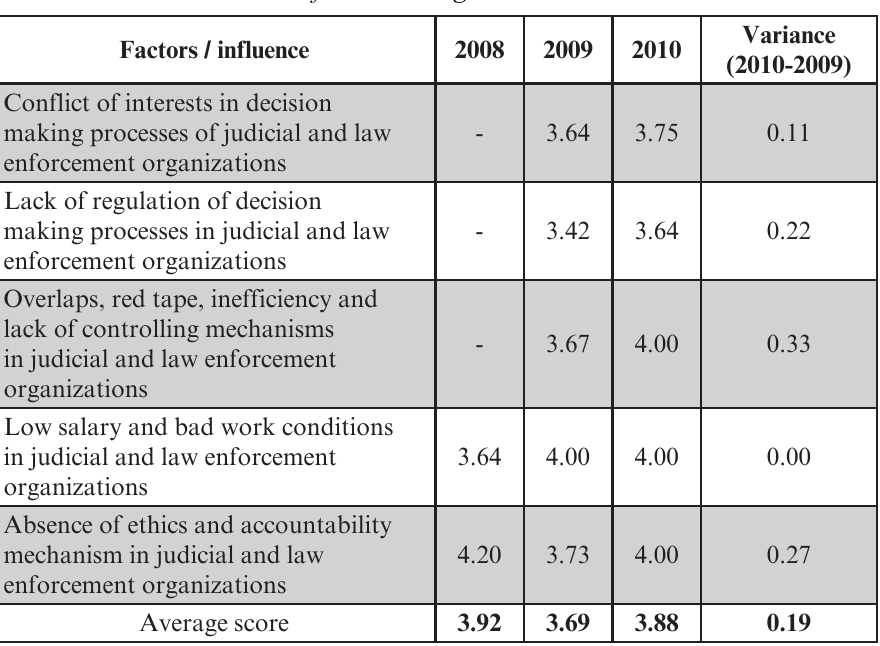
Table 7. Evaluation of factors influencing the corruption in judicial and law